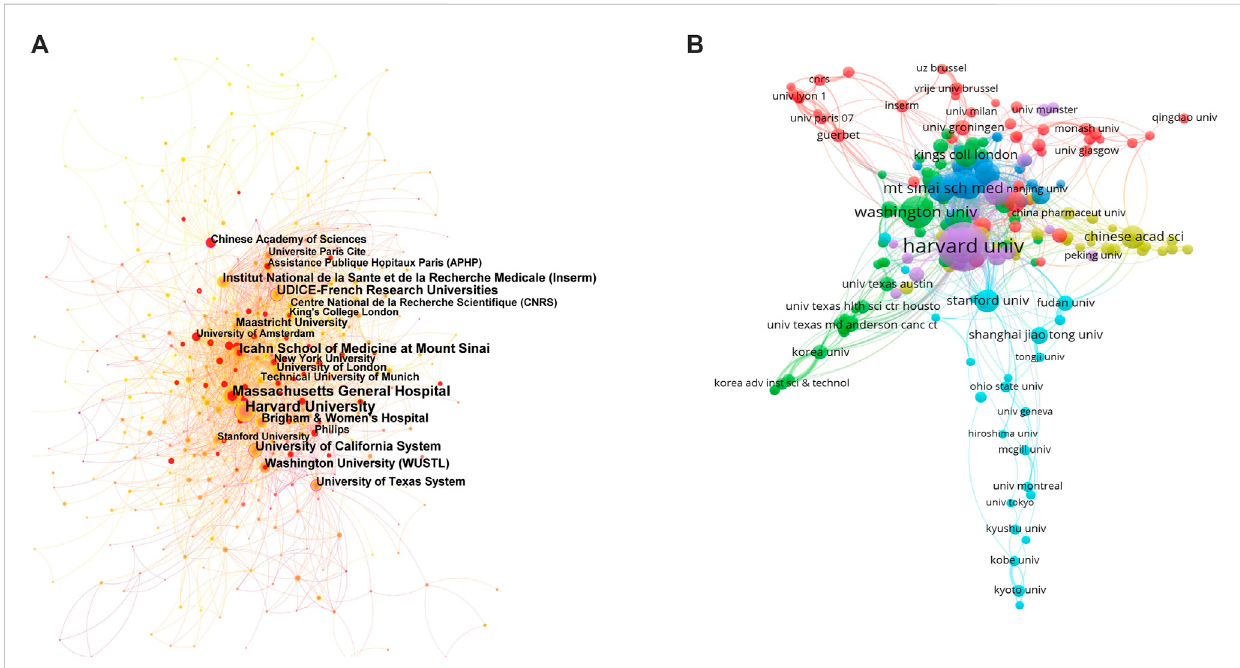
FIGURE 4 (A) The network of collaborating institutions performed with CiteSpace. (B) The network of collaborating institutions created with VOSviewer. The size of the node is proportional to the count of an institution ’ s publications, and links between nodes represent the intensity of collaborations.